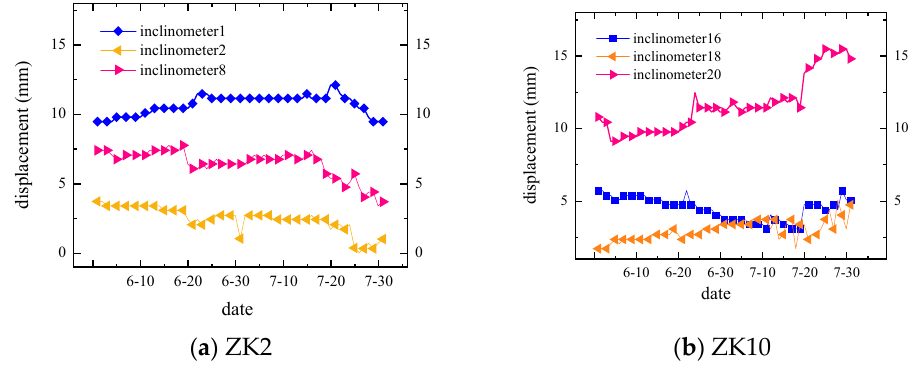
Figure 8. Sketch map of underground displacement.